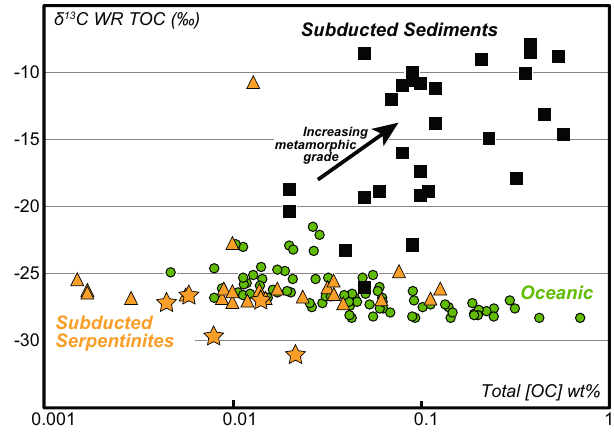
Fig. 6 Bulk rock δ 13 CTOC versus [CTOC] composition. Comparison between subduction-related (meta-) serpentinites (Orange; Stars = Zermatt, this study), abyssal peridotites (Green) (data as in Fig. 3) and